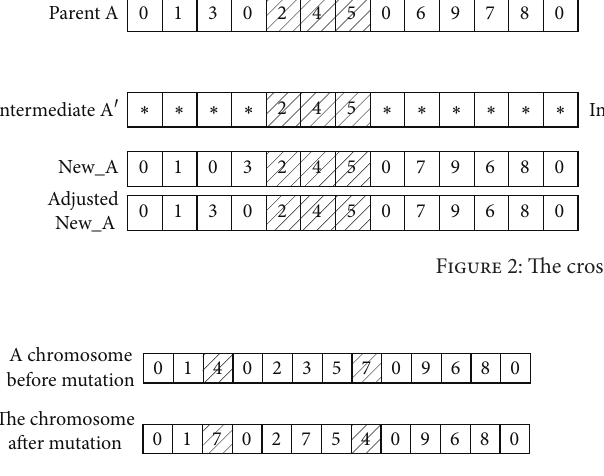
Figure3:Themutationoperator.Note:shadedpartsdenotethegene involved in both crossover and mutation.